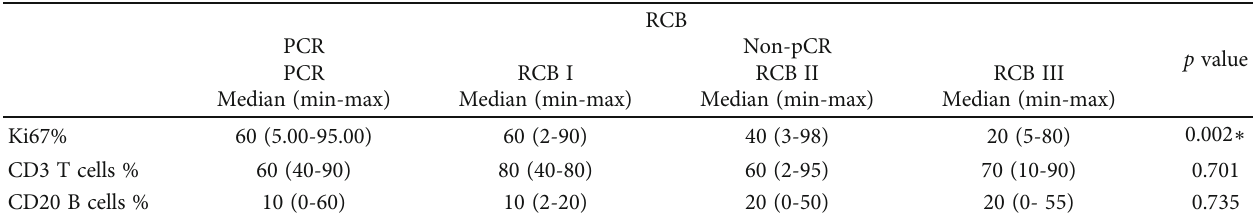
Table 5: Relation between quantitative parameters and RCB classes (Mann – Whitney test).